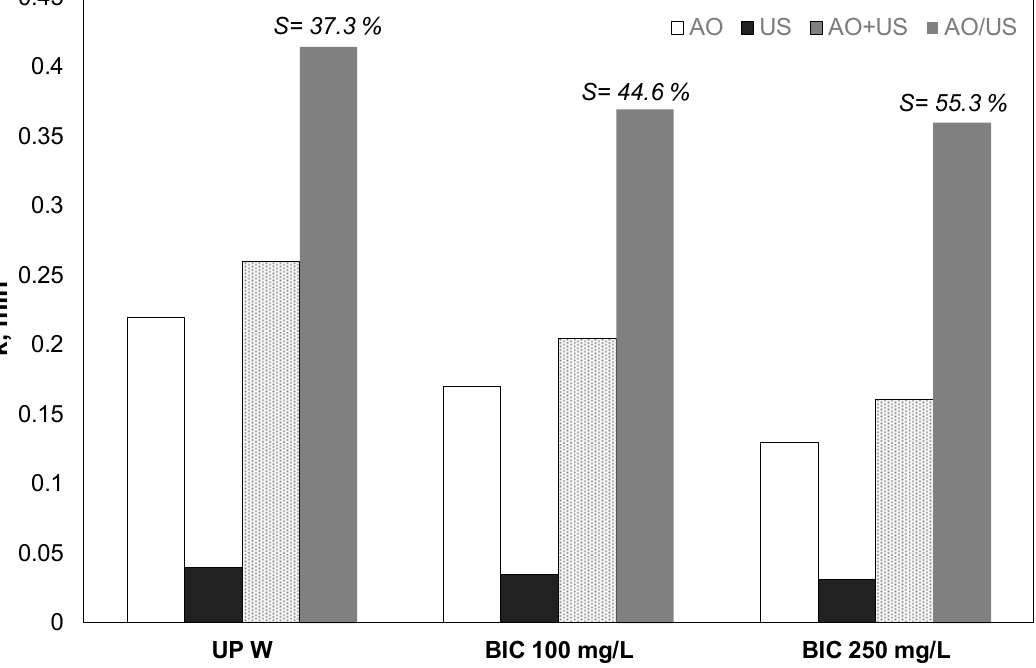
Figure 5. E ff ect of humic acid on the kinetic constant for the removal of 0.5 mg / L propyl paraben by electrochemical anodic oxidation (AO), ultrasound (US), theoretical sum (AO + US) and combined (EO / US) process [Na 2 SO 4 ] = 0.1 M, 3.75 mA / cm 2 , 36 W / L at 20 kHz and inherent pH. UPW: Ultrapure water and 0.1 M Na 2 SO 4 , HA: Humic